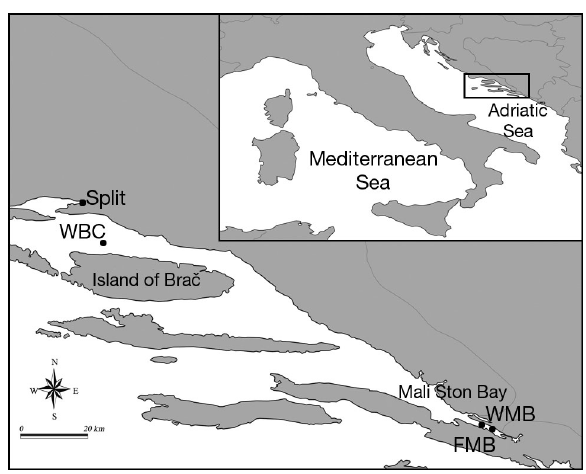
Fig. 1. Sampling locations of gilthead sea bream Sparus au- rata along the eastern Adriatic Sea coast. Inset: central/ southeastern Europe, with the sampling area outlined with a rectangle. WBC: wild population from Bra < Channel; WMB, FMB: wild and farmed populations from Mali Ston